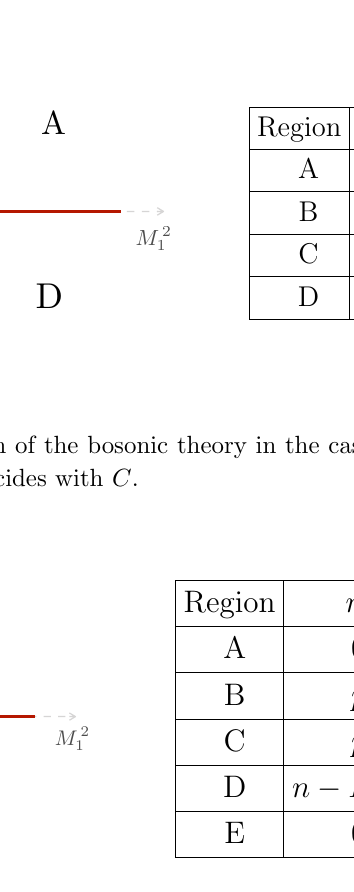
Figure 9 . Phase diagram of the bosonic theory in the case p double condensation coincides with C + D , including the blue